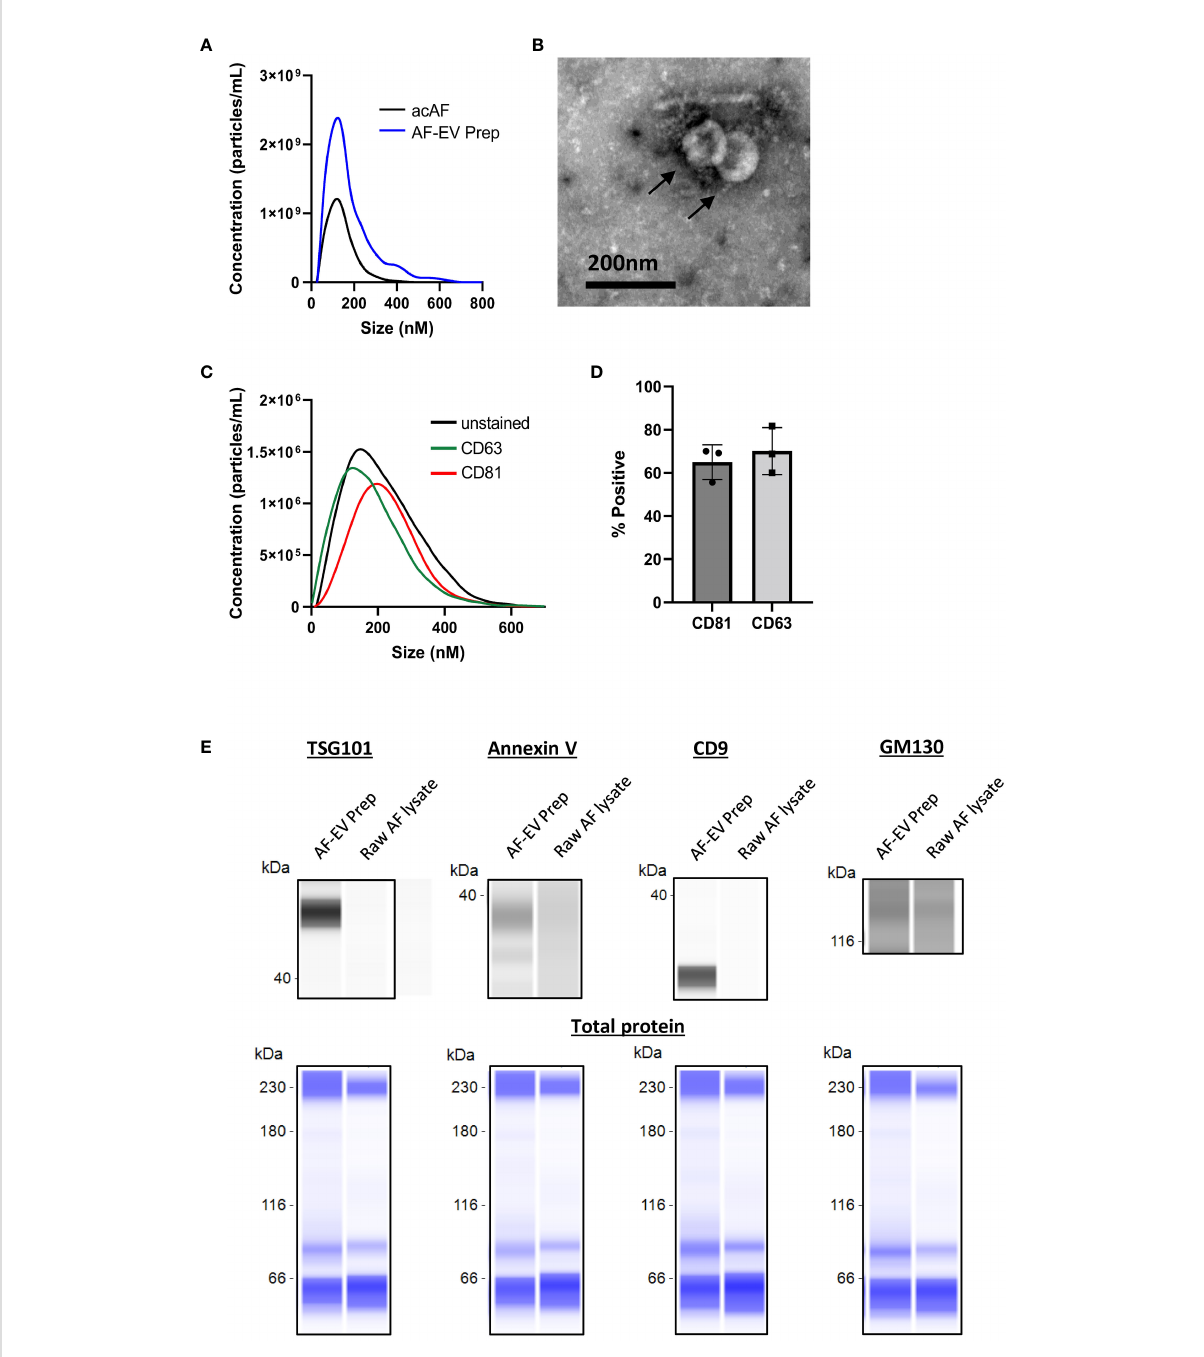
FIGURE 3 Characterization of AF-EVs (A) Comparison of nanoparticle populations between AcAF and EV Preparation samples (B) Transmission electron microscopy image of vesicles within EV preparation (C) Representative CD81+ and CD63+ particle populations in relation to total particle population of EV preparation (D) Percentage of particles in EV preparation expressing exosomal markers CD81 and CD63 (Data graphed as mean ± SD; n=3 samples). (E) Representative capillary western blots of EV markers (TSG101, Annexin V, and CD9) and of cellular Golgi body marker (GM130) in AF-EV Preparation samples and in raw, or unprocessed, AF lysate samples (top). The same amount of protein was loaded for each sample and total protein blots are shown in blue below each corresponding sample to visualize total loaded protein